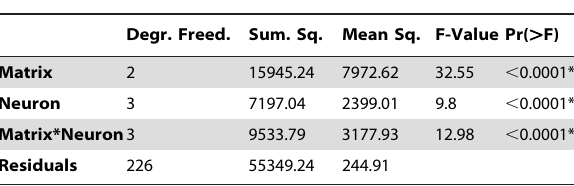
Table 9. Haptotactic Assays. ANOVA Values for %